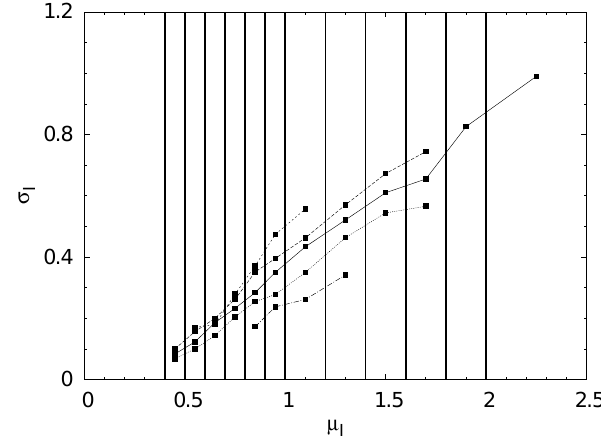
Fig. 4. The probability Pr( γ I ) for the entire dataset at Darwin (solid squares) and for an artificial realization (dashed line) created using the standard probability density S(D R ) . The shaded regions indi- cate different skewness classes.